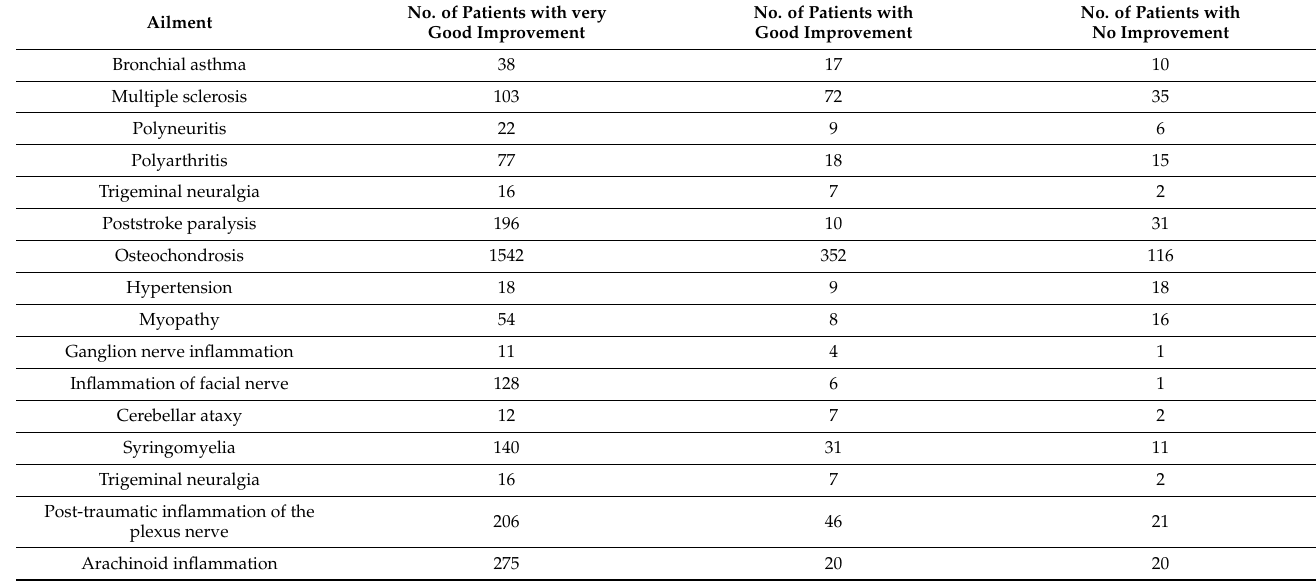
Table 2. Dr. Ludyanski’s experience with bee venom in treating different ailments in a Russian hospital [72]. Ailment